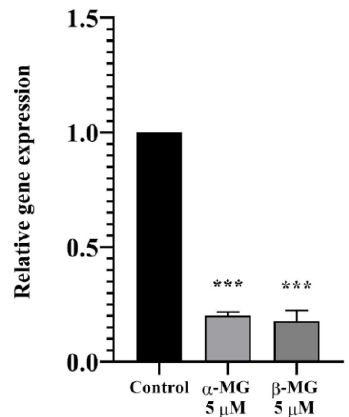
Figure 5. The relative mRNA levels of ABCB1 gene after being treated with α -MG and β -MG quantified by the real-time RT-PCR. ( n = 3) (*** p < 0.001, compared to the control).